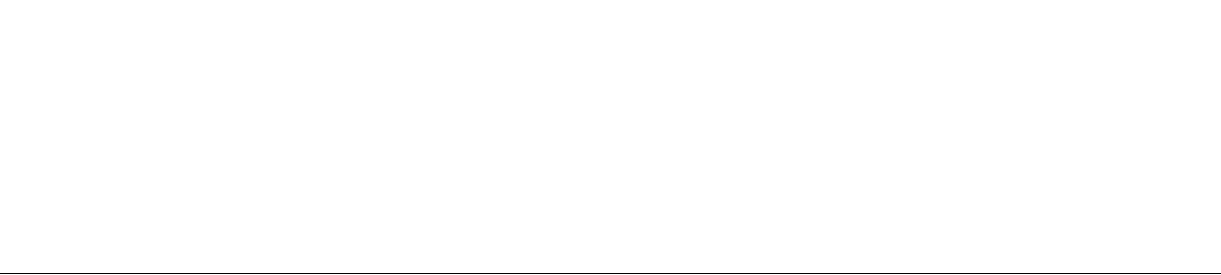
FIGUREA8 | Hierarchical cluster analysis of relative abundances of genes in allTIGRFAMs grouped into functional categories . Data were standardized by functional category before clustering to avoid biasing